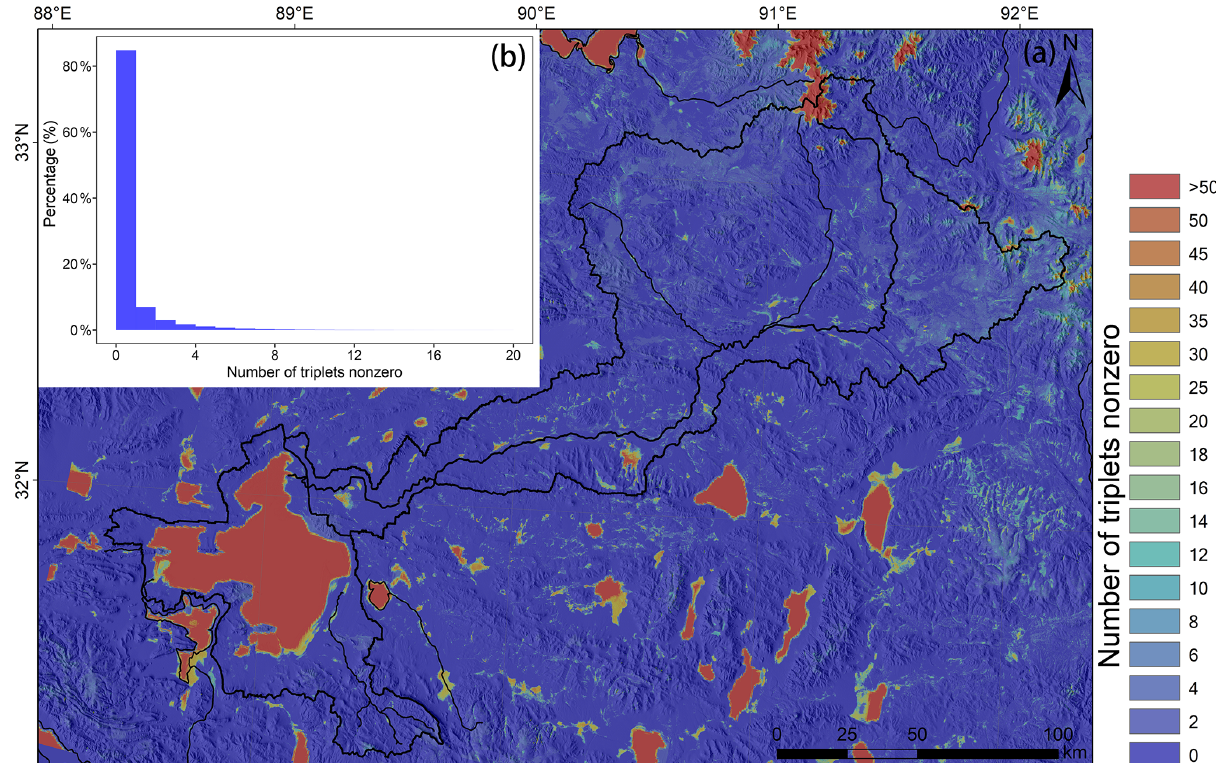
Figure 9. (a) Map of the number of interferogram triplets with nonzero integer ambiguity T int (Eq. 4), (b) histogram illustrating the distribu- tion of T int values within the Selin Co watershed excluding glaciers and